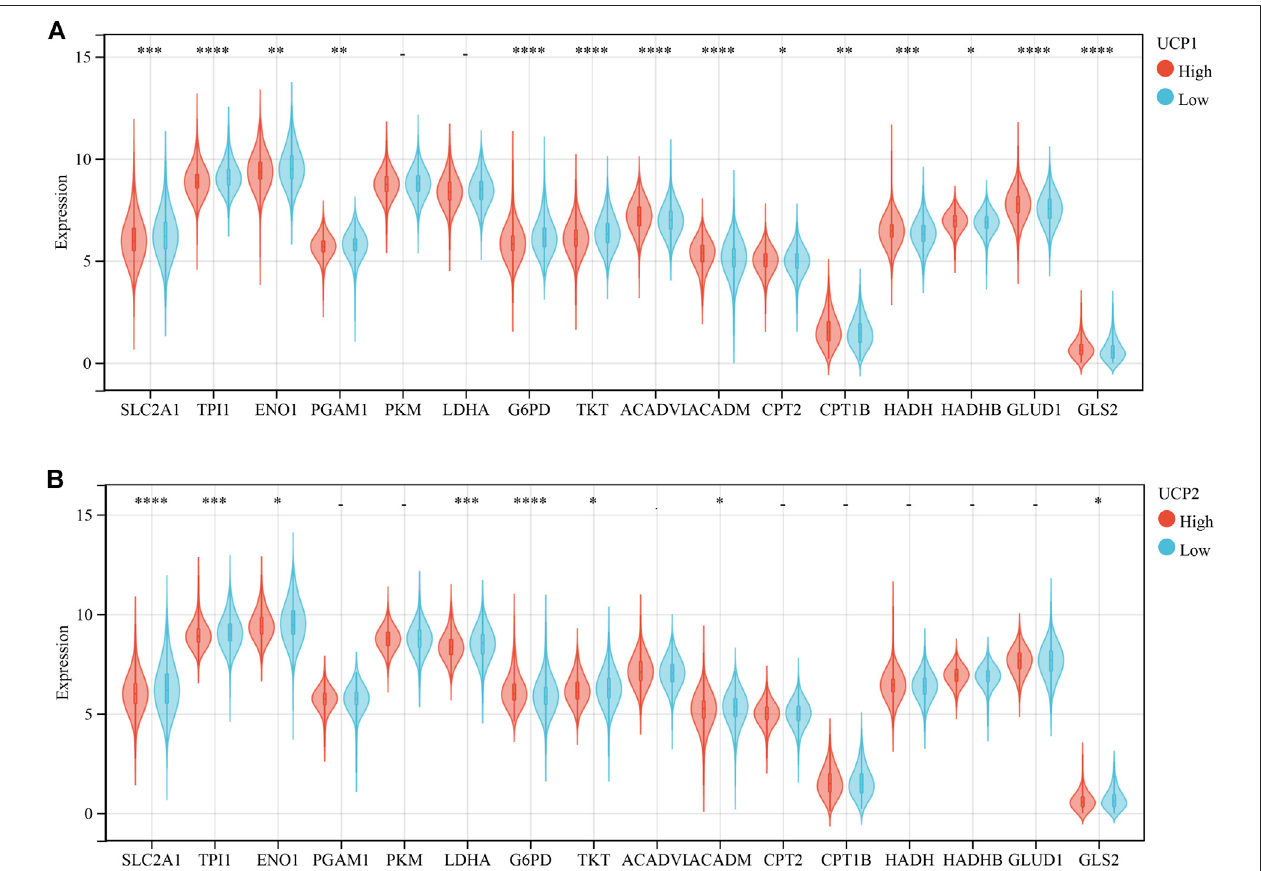
FIGURE 4 | Correlation analysis between UCPs and genes related to metabolism-related gene. (A) Correlation analysis between UCP1 and genes related to glycolysis,pentosephosphatepathway,fattyacidoxidation,andglutaminemetabolism. (B) CorrelationanalysisbetweenUCP2andgenesrelatedtoglycolysis,pentose phosphate pathway, fatty acid oxidation, and glutamine metabolism. The statistical difference was compared through the student t-test. * p < 0.05; ** p < 0.01; *** p < 0.001; **** p < 0.0001.